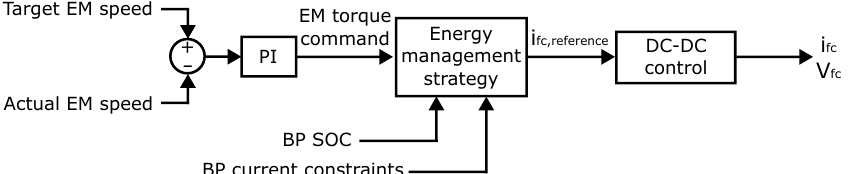
Figure 13. DC-DC efficiency curve as function of the input current. Figure 13. DC–DC efficiency curve as function of the input